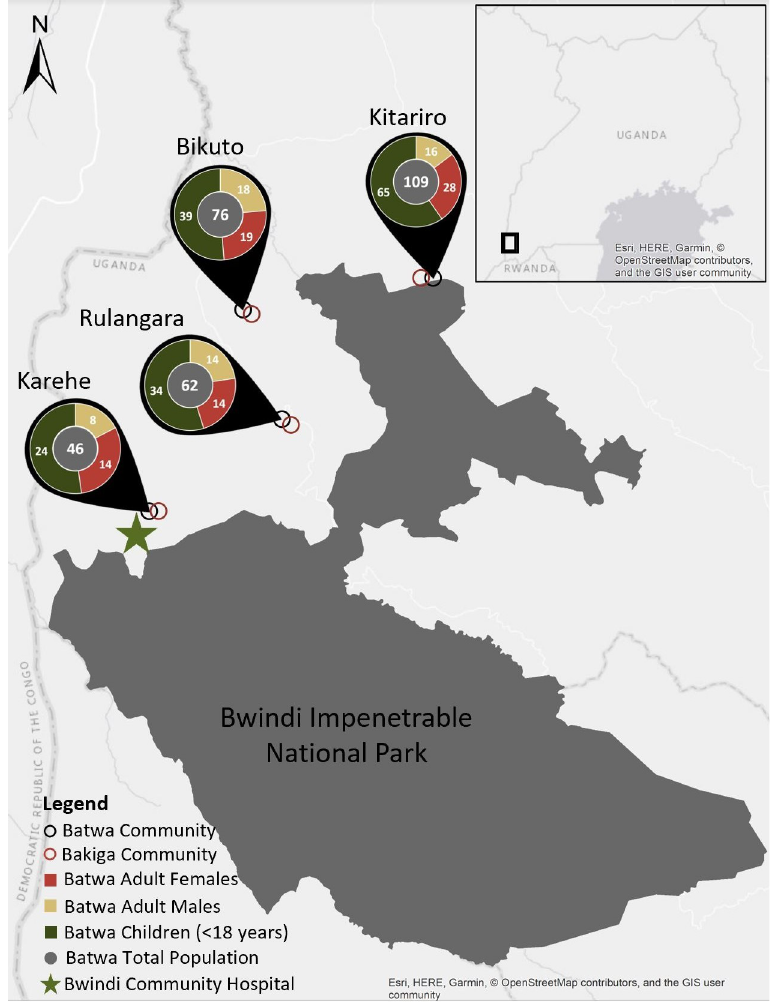
Fig 2. Map of community locations and Batwa populations in Kanungu District, Uganda, which participated in focus group discussions. Map not to scale. Base map and data from OpenStreetMap and OpenStreetMap Foundation. Population data for year